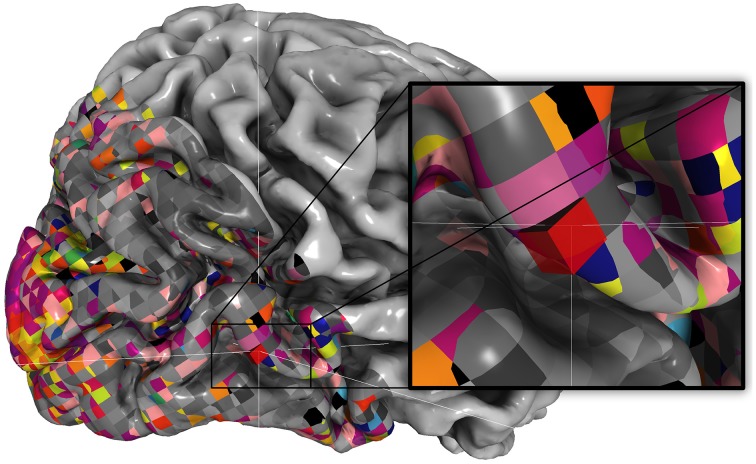
Retinotopic data for example subject. Pixel-based mapping in pycortex renders voxels true-to-form. Here, a retinotopic map as in Hansen et al. (2007) is plotted using webgl. Note that the slanted slice prescription and the isotropic voxel size is easily visible due to pixel-based mapping and nearest-neighbor sampling. The inset shows how a single voxel intersects the surface.